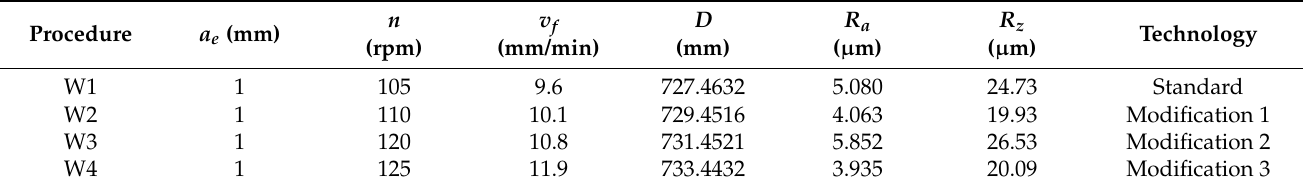
Table 3. Parameters and results of boring the large-size workpiece